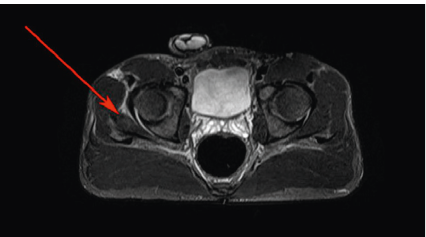
Figure 1: MRI (red arrow) shows moderate intramuscular edema at the ventral aspect of the right gluteus minimus muscle with mild muscle